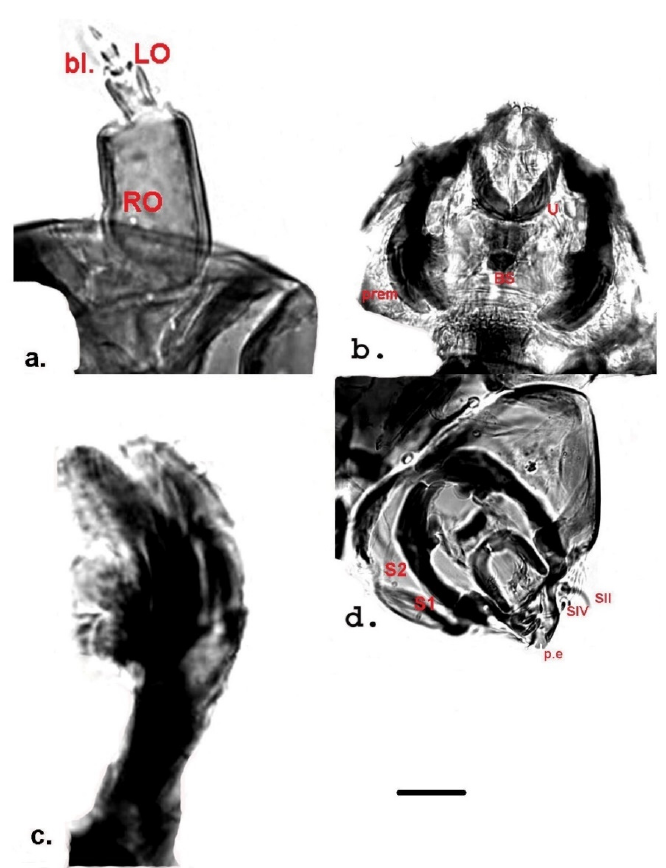
Figure 3. Larval morphology of Belgica antarctica (Jougla Point). ( a ) Antenna—blade (bl); Ring Organ (RO); Lauterborn—organ (LO); ( b ) Ungula (U); premandibles (prem.) and basal sclerite (BS); ( c ) Premandible (prem.); ( d ) Pecten epipharyngis (p.e.) and posterior seta (SII) + larger peg of bisensillum (SIV), S1 and S2 of the clypeus; Scale bar 10 µ